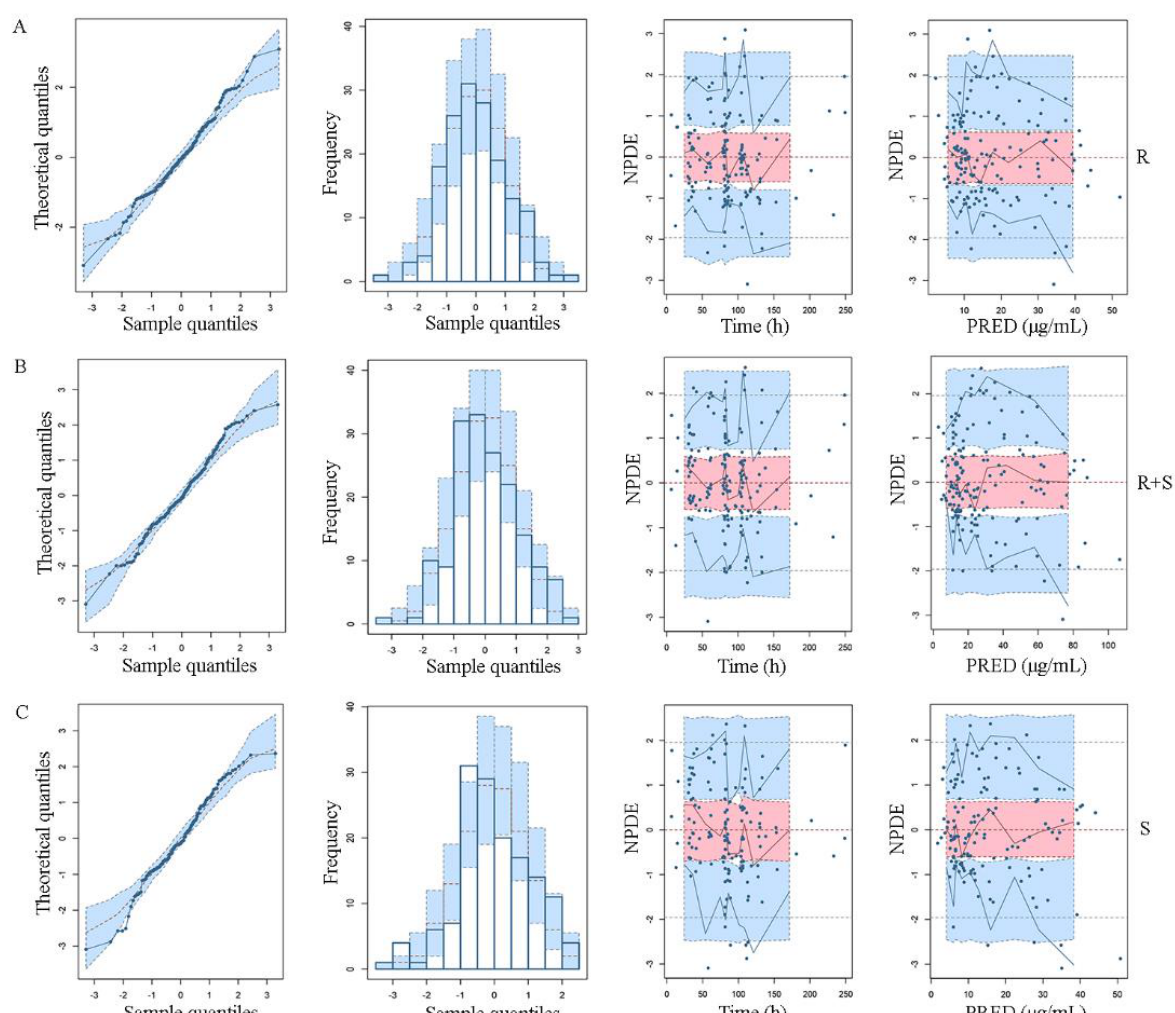
Figure 2. Normalized prediction distribution error (NPDE) plots for the final population pharmacokinetic models: ( A ) R latamoxef, ( B ) R + S latamoxef, and ( C ) S latamoxef. From left to right, these plots are quantile-quantile plot of NPDE versus the expected standard normal distribution, histogram of NPDE with the density of the standard normal distribution overlaid, scatterplot of NPDE versus time after dose, and scatterplot of NPDE versus population prediction (PRED), respectively.